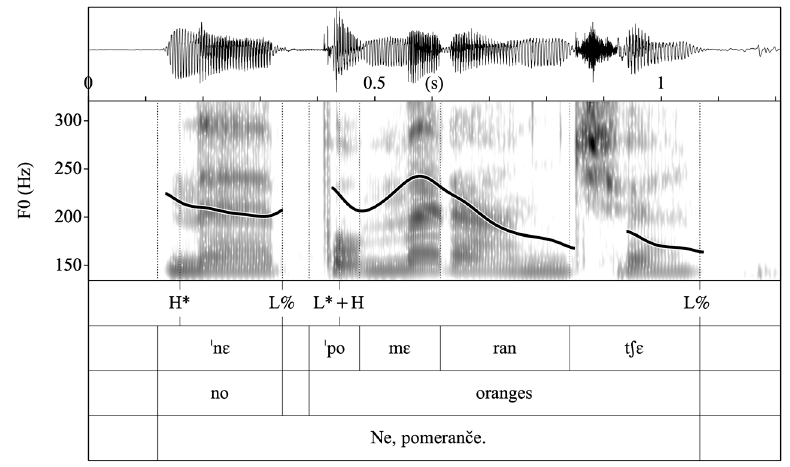
Figure 1. Waveform, spectrogram and F0 trace of the contrastive focus statement No, oranges! in L1 Czech produced with L*+H L%.